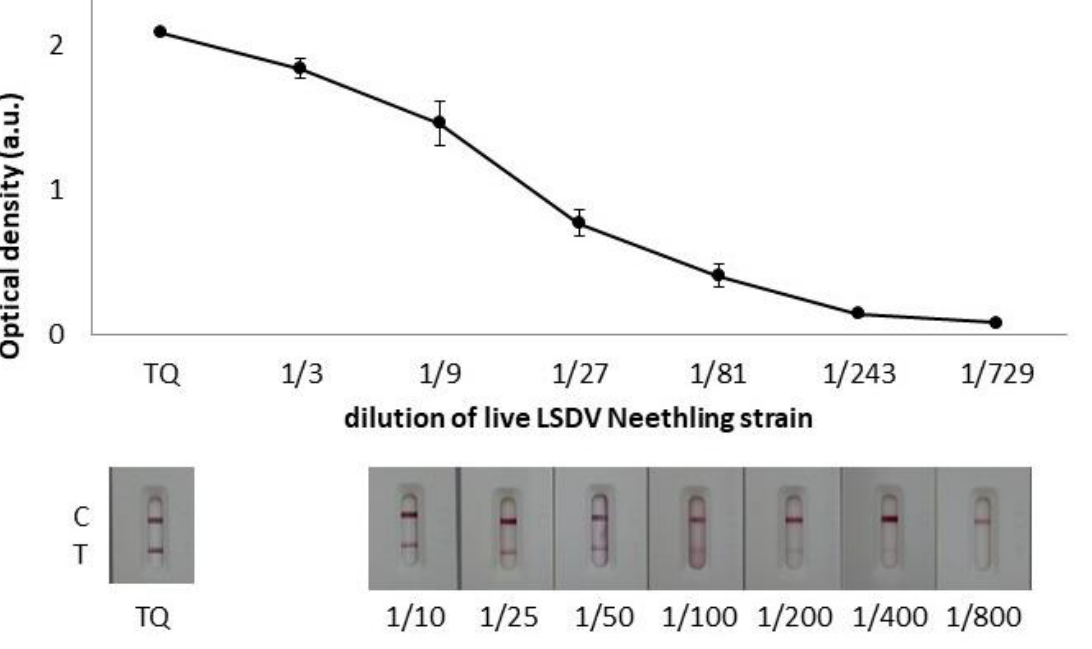
Figure 4. LSD_LFIA sensitivity assessment by testing serial dilution of live LSDV Neethling strain titrated as 10 6 TCID 50 /mL in parallel with the ELISA.